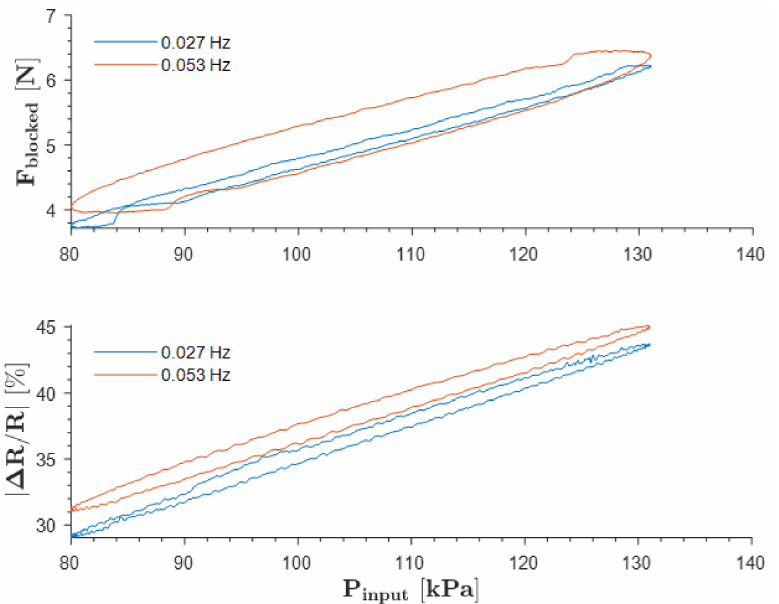
Figure 6. Hysteresis of SoHapS under peak-to-peak 50 kPa input pressure at operating frequencies of 0.027 Hz and 0.053 Hz.